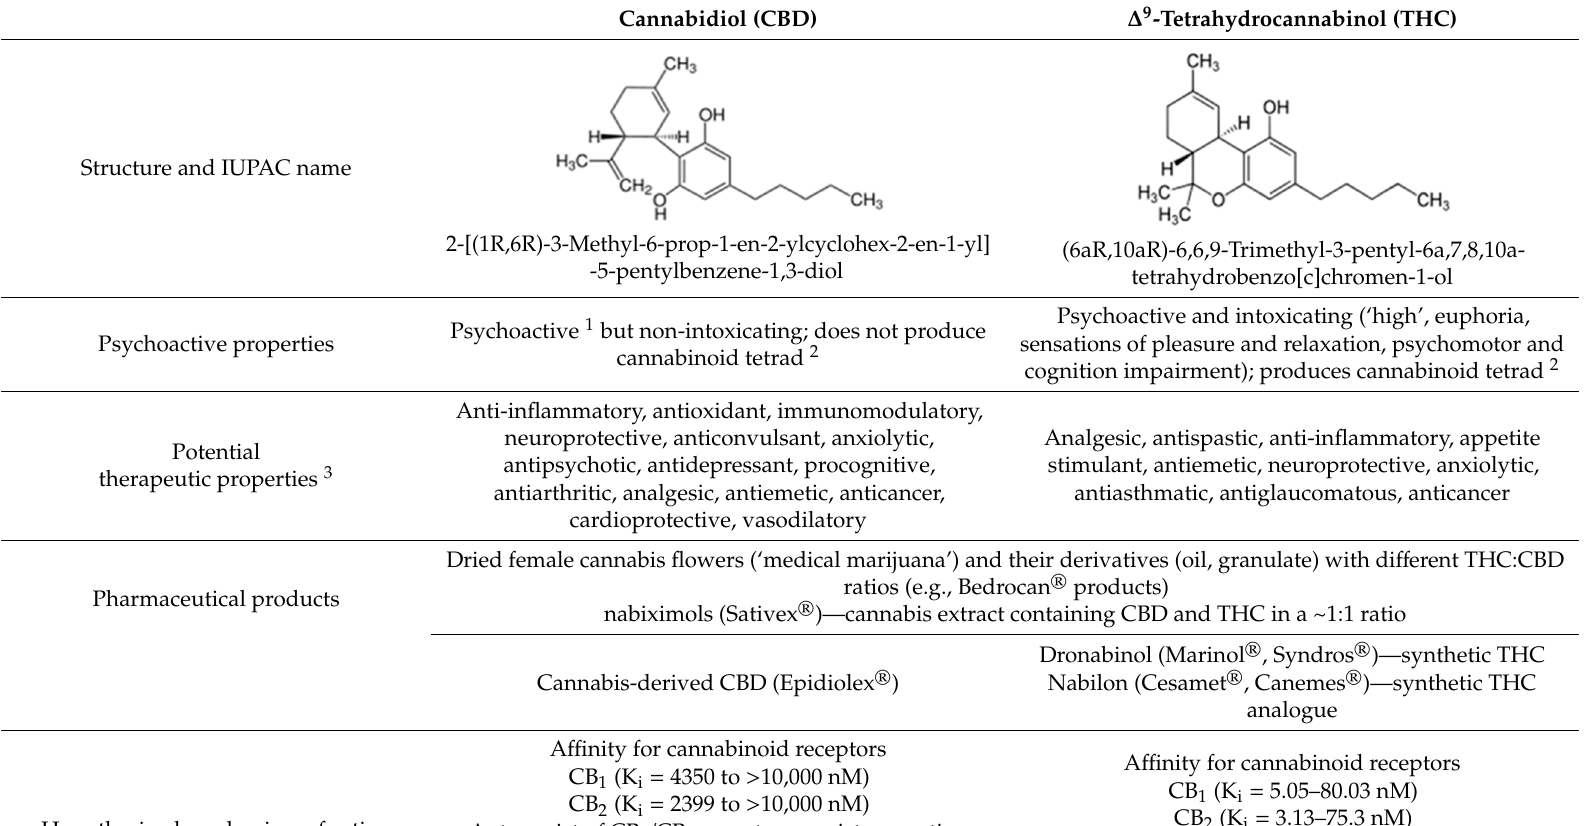
Table 1. Comparison of the main cannabidiol and ∆ 9 -tetrahydrocannabinol properties [4,6,8–33]. Cannabidiol (CBD) ∆ 9 -Tetrahydrocannabinol (THC)